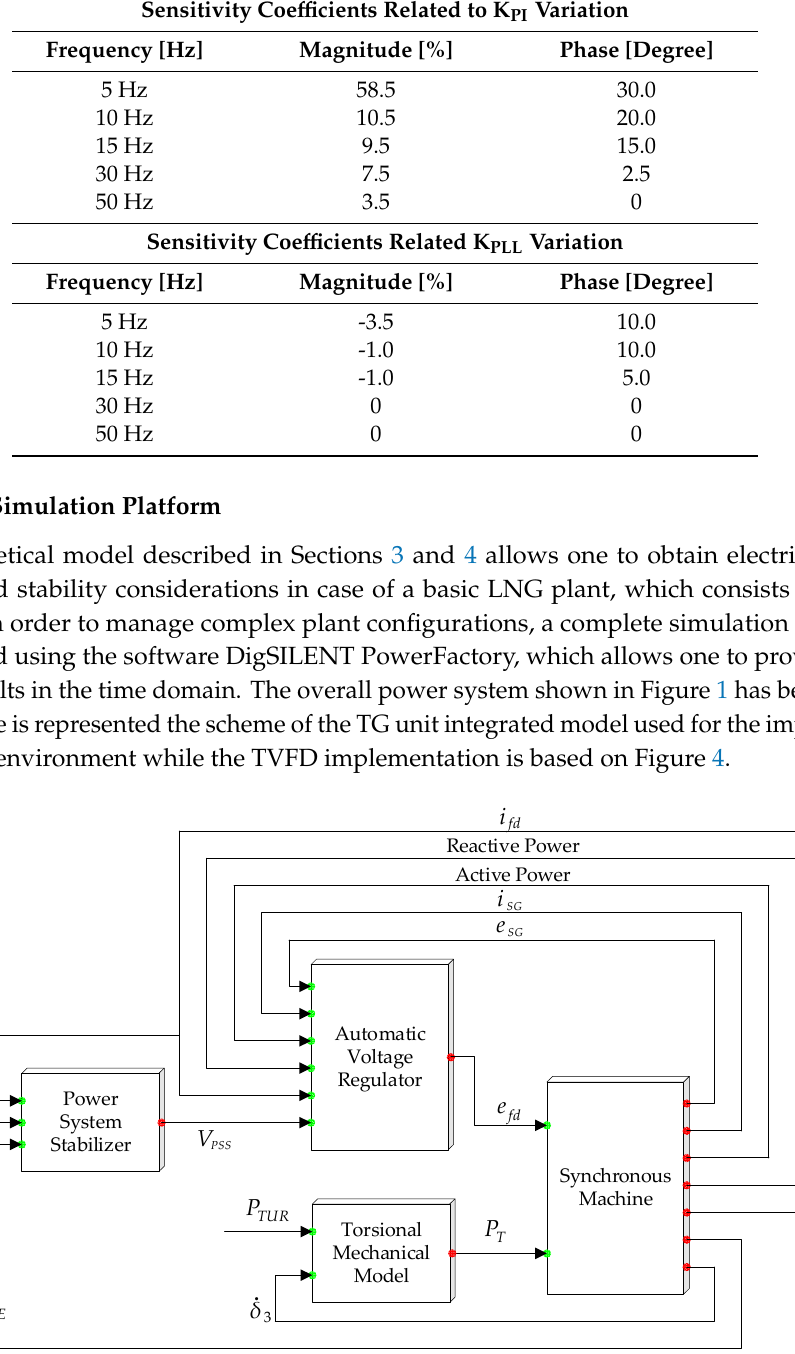
Figure 7. TG unit model implementation scheme.